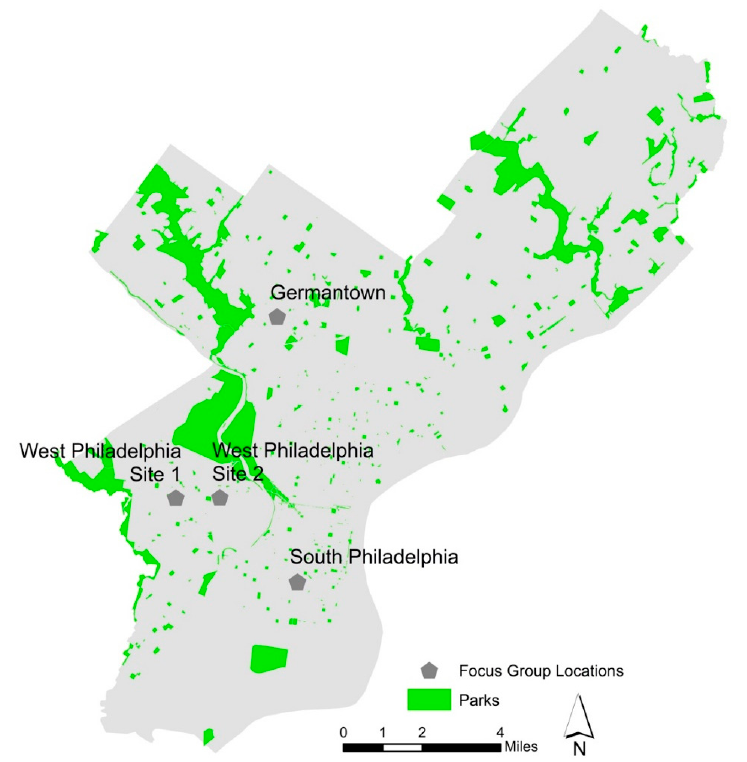
Figure 1. Focus group locations compared to the location of parks in Philadelphia,